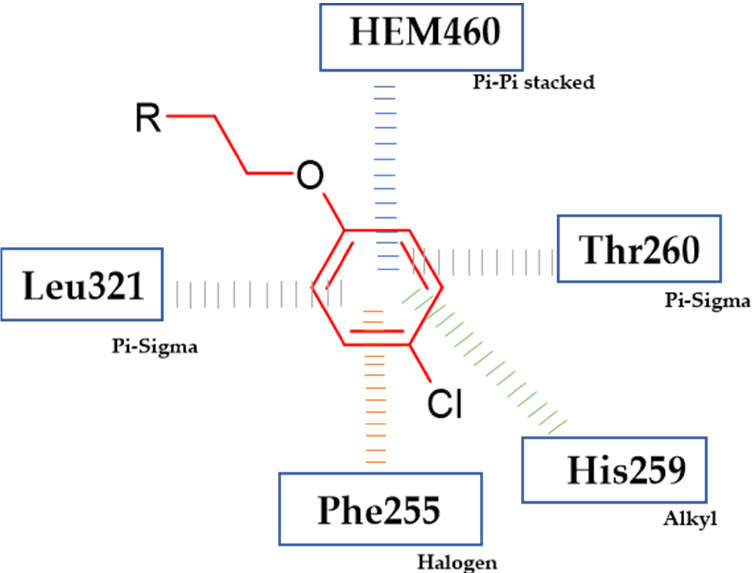
Figure 19. Schematic representation of the hydrophobic interactions (lines) formed by a phenoxy group with an active site of cytochrome 450 14 α -sterol demethylase enzyme CYP51 (R is the rest of the compound structure).